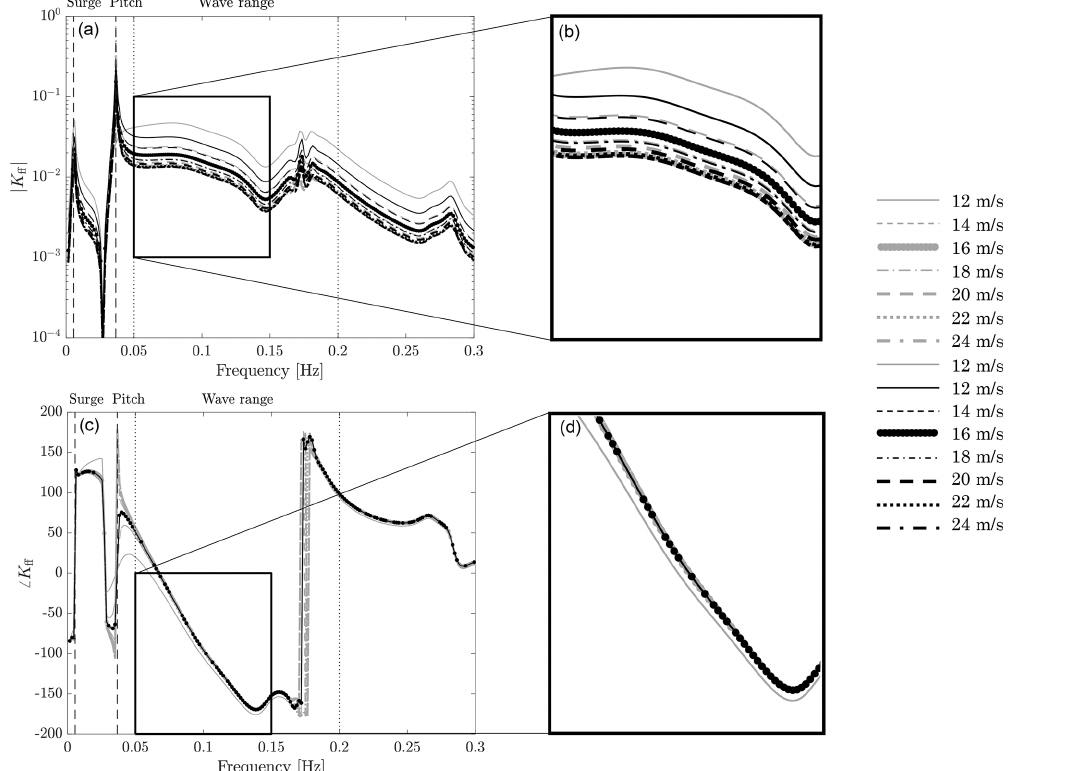
Figure 7. The scheduled feedforward controllers K ff ( β ) = c ff ( β ) K ff ( U ) (black) obtained from the scheduling of the 16m/s controller K ff ( U ) (dotted line) are compared to the model-inversion controllers K ff ( U i ) (grey) for different above-rated wind speeds U i = 12 , 13 ,..., 24m/s. Magnitude (a, b) and phase (c, d) . Wave range is the frequency range where the linear wave is